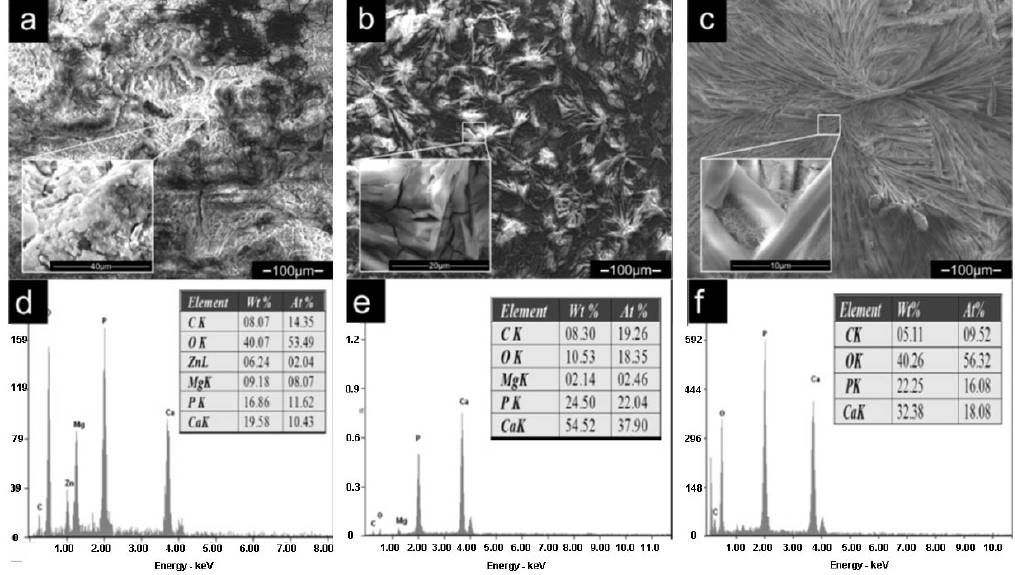
Figure 5. Corrosion morphologies and corresponding EDS of corrosion products: ( a ) and ( d ) for uncoated ZK60; ( b ) and ( e ) for DCPD coated ZK60; ( c ) and ( f ) for HA coated